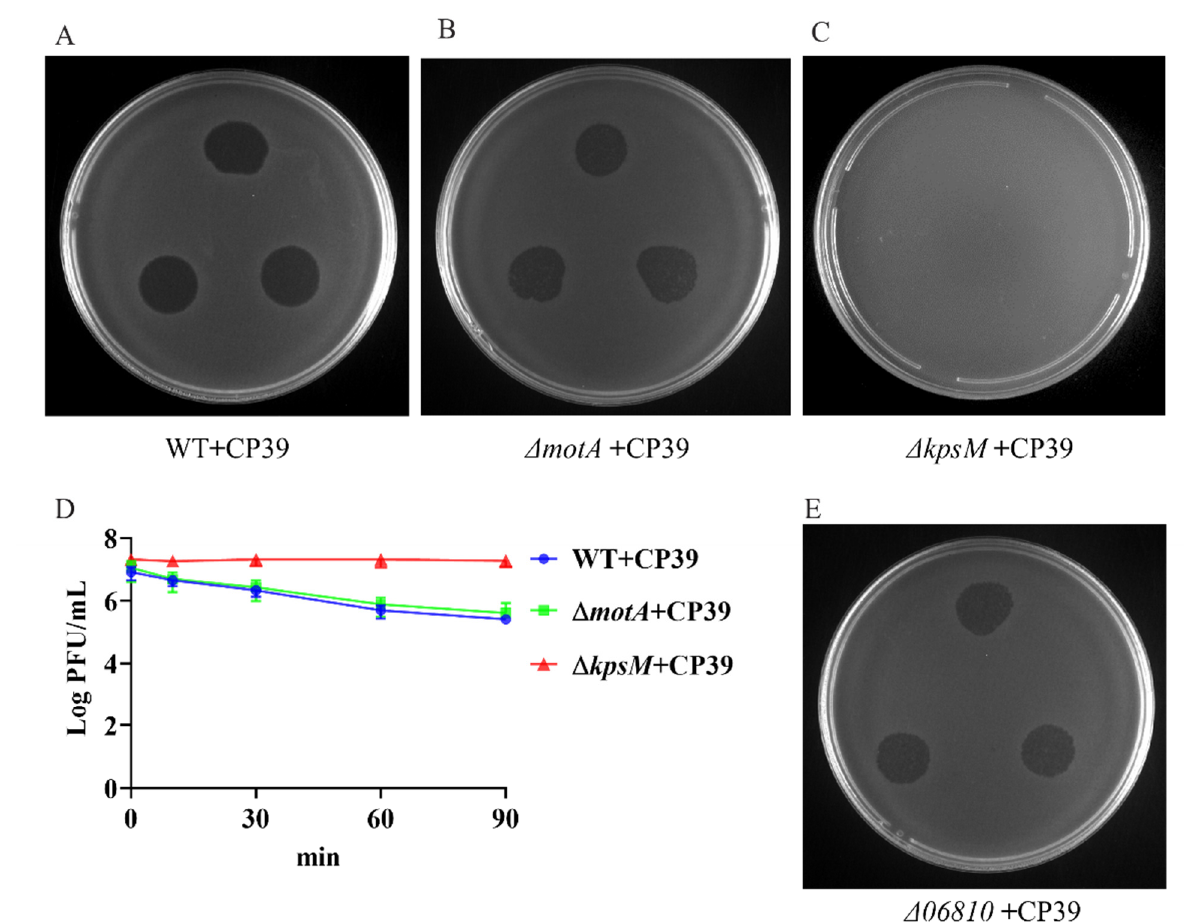
Figure 2. Identification of phage CP39 receptor type. ( A ) Sensitivity of NCTC12662 strain to CP39. ( B ) Sensitivity of motA mutant strain to CP39. ( C ) Sensitivity of kpsM mutant strain to CP39. ( D ) The adsorption assay of CP39 to NCTC12662, motA and kpsM mutant strain. motA and kpsM mutant strains were infected with CP39 for 100 min at an MOI of 0.01. The same culture NCTC12662 served as the control. ( E ) Sensitivity of Δ 06810 mutant to CP39.